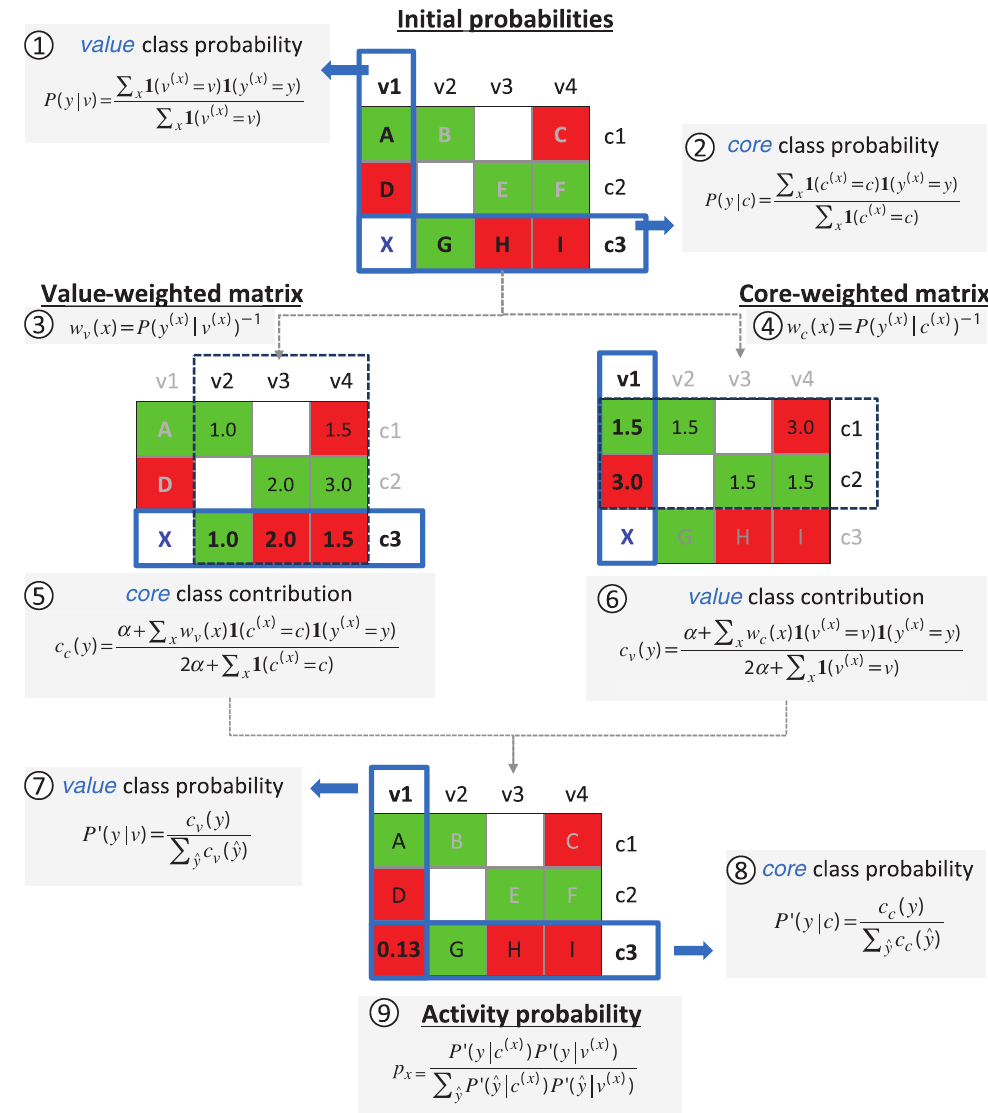
Figure 3. Predictions based on conditional probabilities of activity. Steps and equations required to derive probabilities of activity from SARMs for prediction of virtual compound X are shown using a model SARM with nine compounds (A–I) that contain three cores ( c1 – c3 ) and four values ( v1 – v4 ). Matrix cells are color-coded according to compound activity (red, inactive; green, active). In the first step, initial class probabilities are calculated for all cores and values using equation 2 and 1, respectively. Value- and core-weighted matrices are then derived via equations 4 and 3. The class contribution of core c3 is obtained from the value-weighted matrix using equation 5. Analogously, the class contribution of value v1 is obtained from the core-weighted matrix using equation 6. The value and core class contributions are then normalized using equations 7 and 8. Finally, the activity probability p of 0.13 is obtained for X by combining the normalized core c3 and value x v1 class probabilities using equation